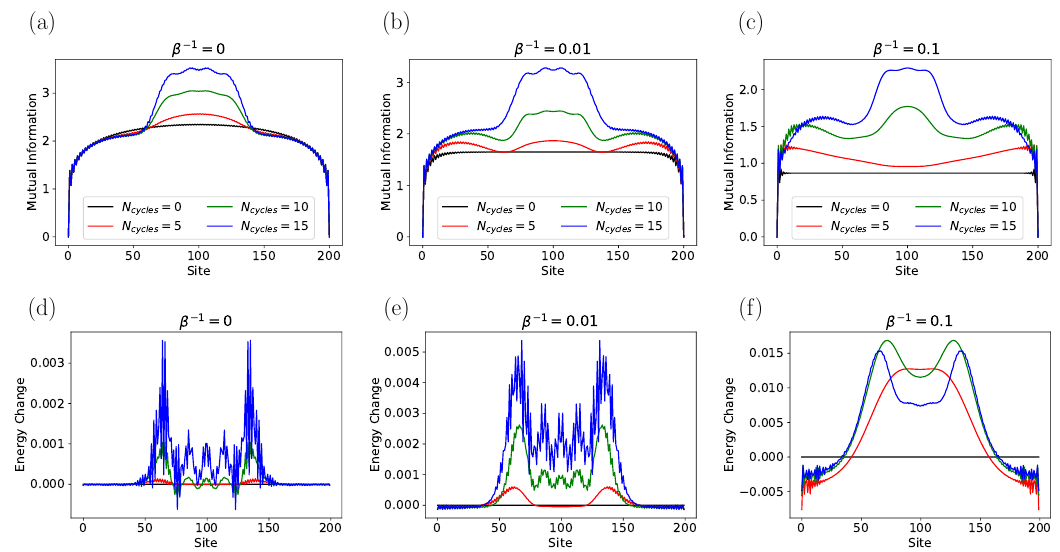
Figure 5: (a-c) Scaling of mutual information I ([ 0, x ) , ( x , L ]) in the heating / L = 0.95, T / L = 0.05, L = 200 for different initial temperatures, phase, T 0 1 β − 1 = 0,0.01,0.1. A kink structure is observed at the position of the two horizons x ∗ ≈ 55 and L − x ∗ , as predicted by CFT. (d-f) Energy density E ( x , t ) − E ( x ,0 ) in the / L = 0.95, T / L = 0.05, L = 200 for different initial temperatures, heating phase T 0 1 β − 1 = 0,0.01,0.1. We observe at x − x ∗ and L ∗ two hotspots in energy density that are building up exponentially in